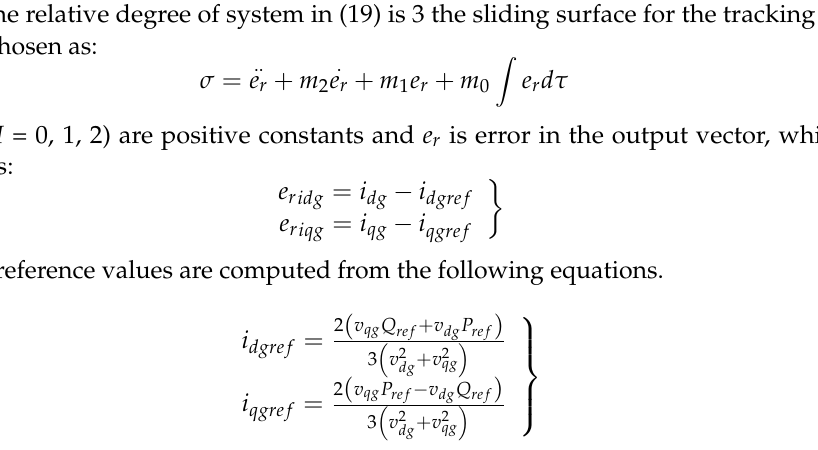
Table 1. Simulation parameter